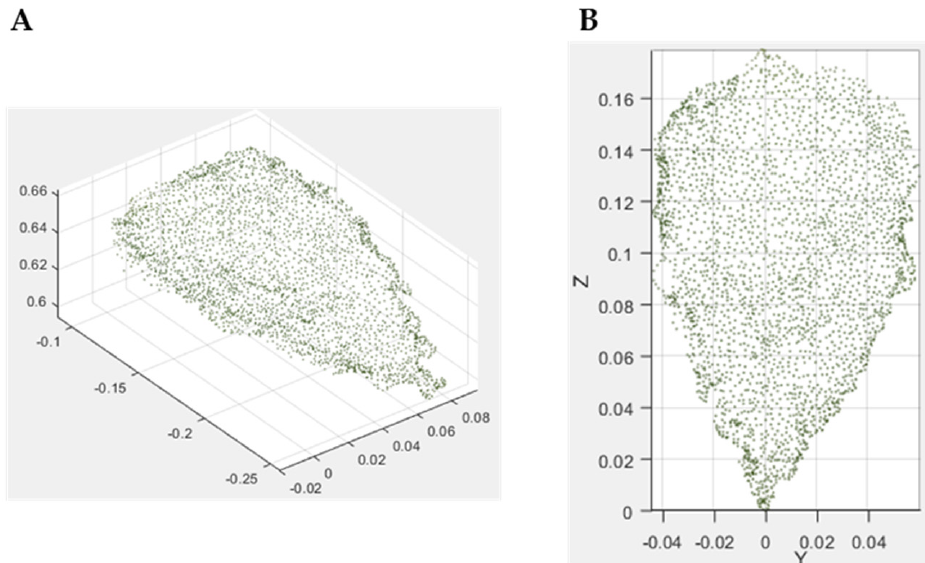
Figure 12. 3D point cloud that is divided: ( A ) leaves, ( B ) stem, internode, nodes; and ( C ) elements that failed to segment.